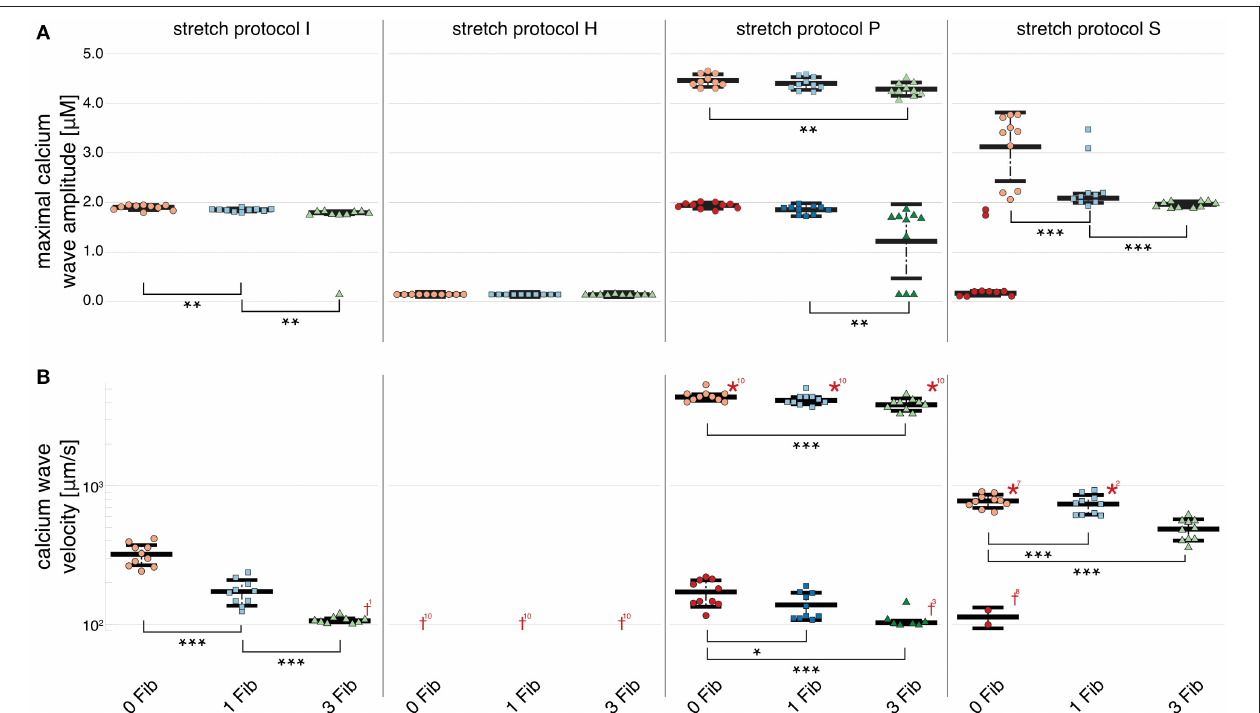
FIGURE 5 | Maximal calcium wave amplitude and calcium wave velocity for simulations for control (red data points), and myocytes with one (blue data points) and two (green data points) coupled fibroblasts. The data points in light colors specify the first spontaneous event and dark colors are used for the following spontaneous event. (A) For stretch patterns I (control), S, and P the maximal calcium wave amplitude significantly ( p < 0.01) decreased the more fibroblasts were coupled to the myocyte. (B) The wave velocity significantly ( p < 0.01) decreased for stretch patterns I (control), S, and P for no fibroblast coupled to three coupled fibroblasts. *, **, *** indicate the statistical significance with p < 0.01, p < 0.05, and p < 0.1,